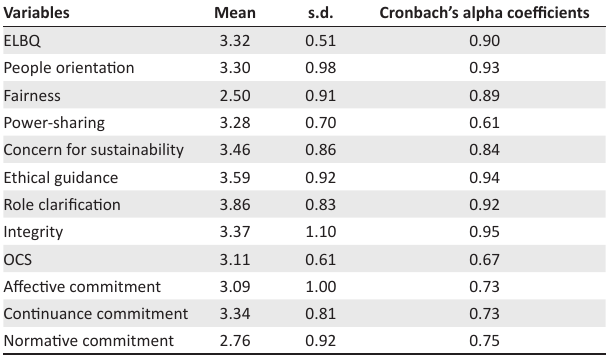
TABLE 1: Descriptive statistics for Ethical Leaders’ Behaviour Questionnaire and Organisational Commitment Scale. Variables Mean s.d.